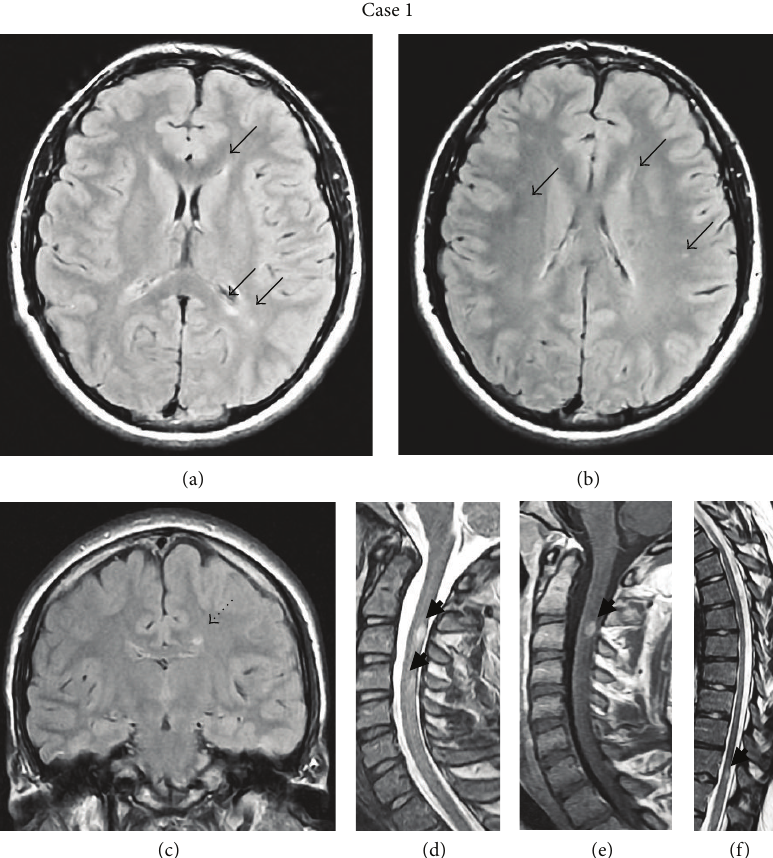
Figure 1: (a) and (b): Axial FLAIR brain MRI of the first patient demonstrating right subcortical and juxtacortical and left periventricular hyperintense lesions (black arrows). (c) Coronal FLAIR brain MRI showing a left periventricular hyperintense lesion (dotted black arrow). (d) Sagittal T2-weighted MRI of the cervical spine showing hyperintense lesions on C3 and C4-C5 level (black arrowheads). (e) The lesion on C3 level appears to be enhanced on T1-weighted image (black arrowhead). (f) Sagittal T2-weighted MRI of the thorasic spine demonstrating a hyperintense lesion on T11 level (black